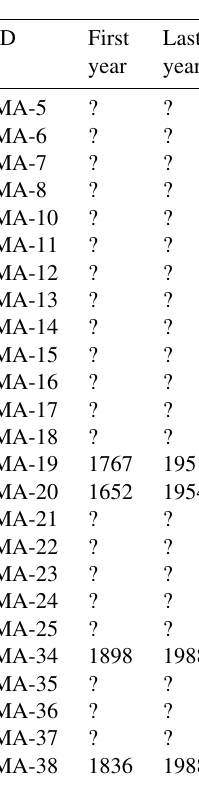
Table 3. Samples from the modern beach (Makhchar,